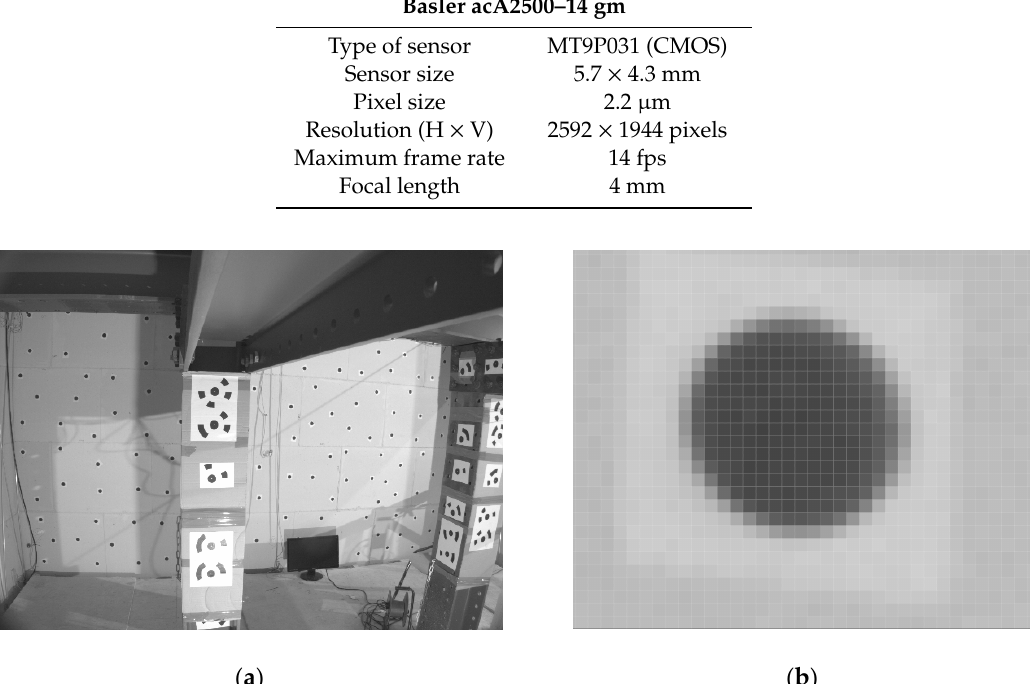
Figure 4. Circular printed targets used for point-tracking technique: ( a ) general view from the upper left camera; ( b ) detailed view of one circular target.